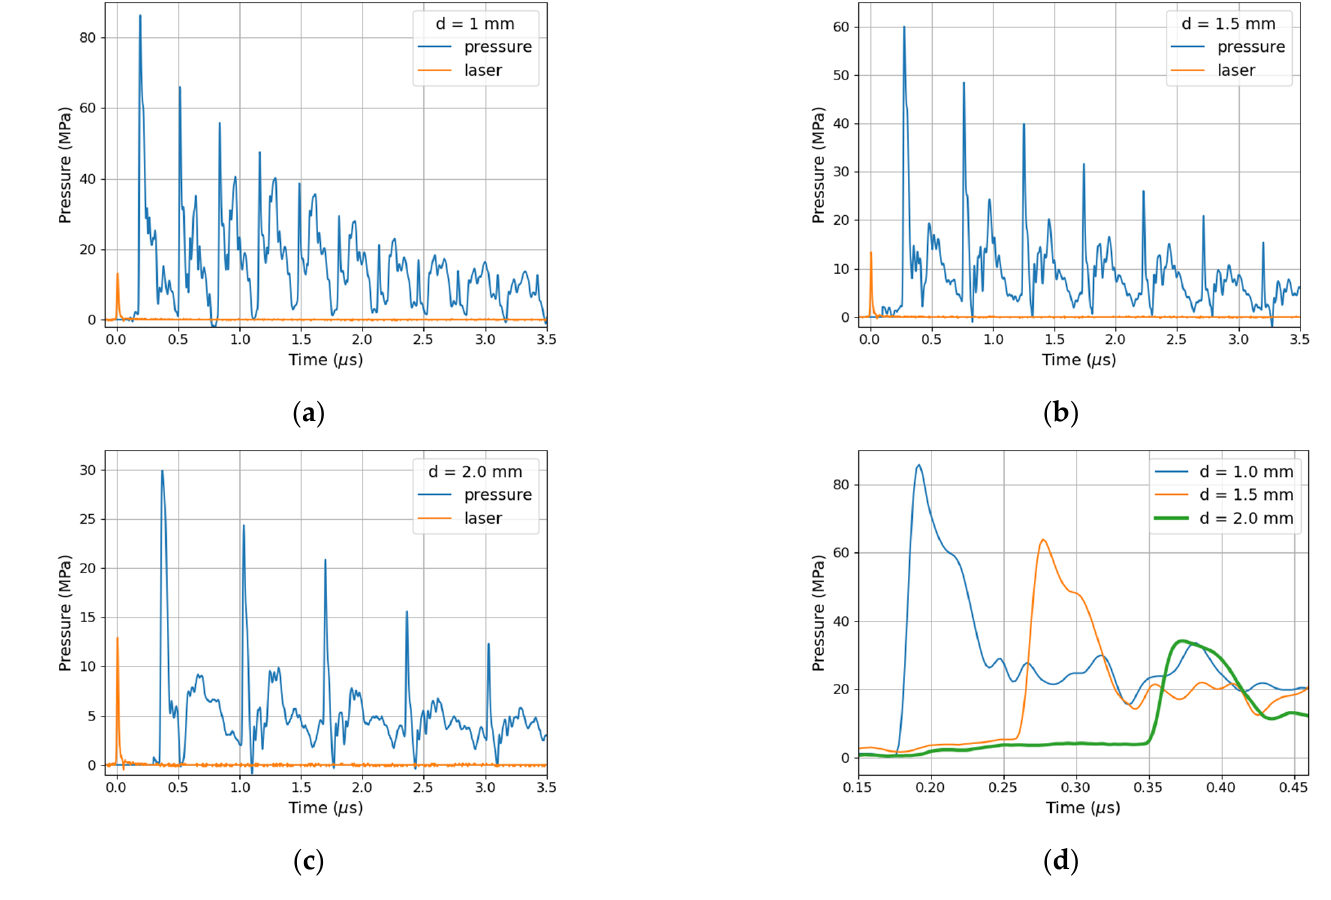
Figure 5. Temporal evolution of pressure registered by PVDF sensor at the back side of the sample. Sample thickness d = 1 ( a ), d = 1.5 ( b ), and d = 2 mm ( c ). Zoom of the first pressure peak for d = 1, 1.5, and 2 mm ( d ). Laser pulse energy of 1 J, pulse duration 10 ns.